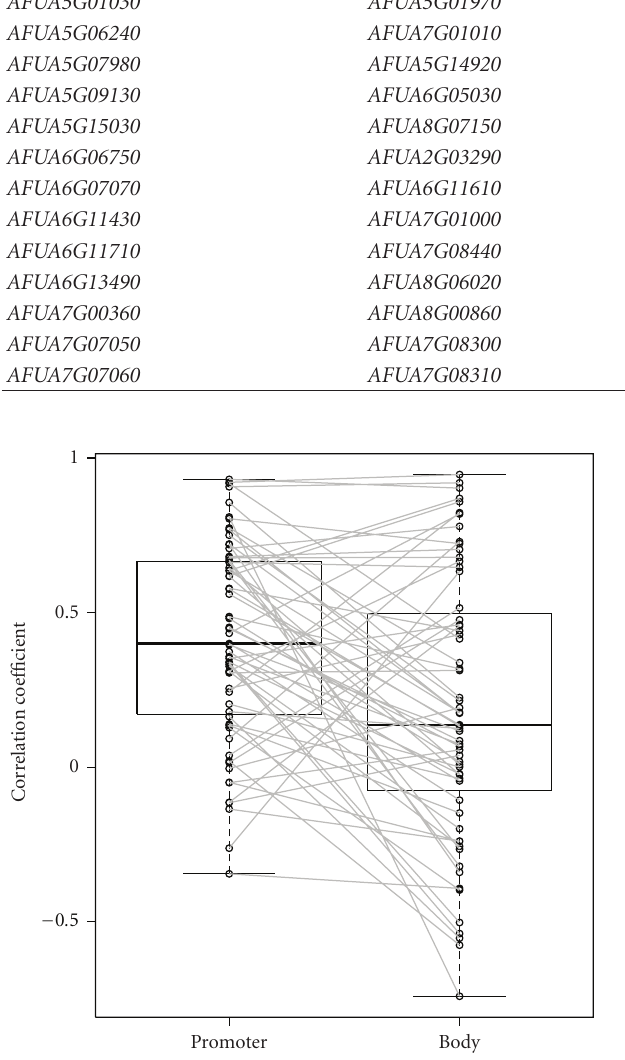
Figure 2: Boxplots of Spearman’s rank correlation coe ffi cients between nucleosome position profiles in the promoters of 347 orthologous gene pairs between Aspergillus fumigatus and Saccha- romyces cerevisiae . The same number of gene pairs was chosen at random to serve as a control. Dots indicate correlation coe ffi cients. The distributions of correlation coe ffi cients did not significantly di ff er ( P - value = 0.28 in Kolmogorov-Smirnov test) between the orthologous gene promoters and the